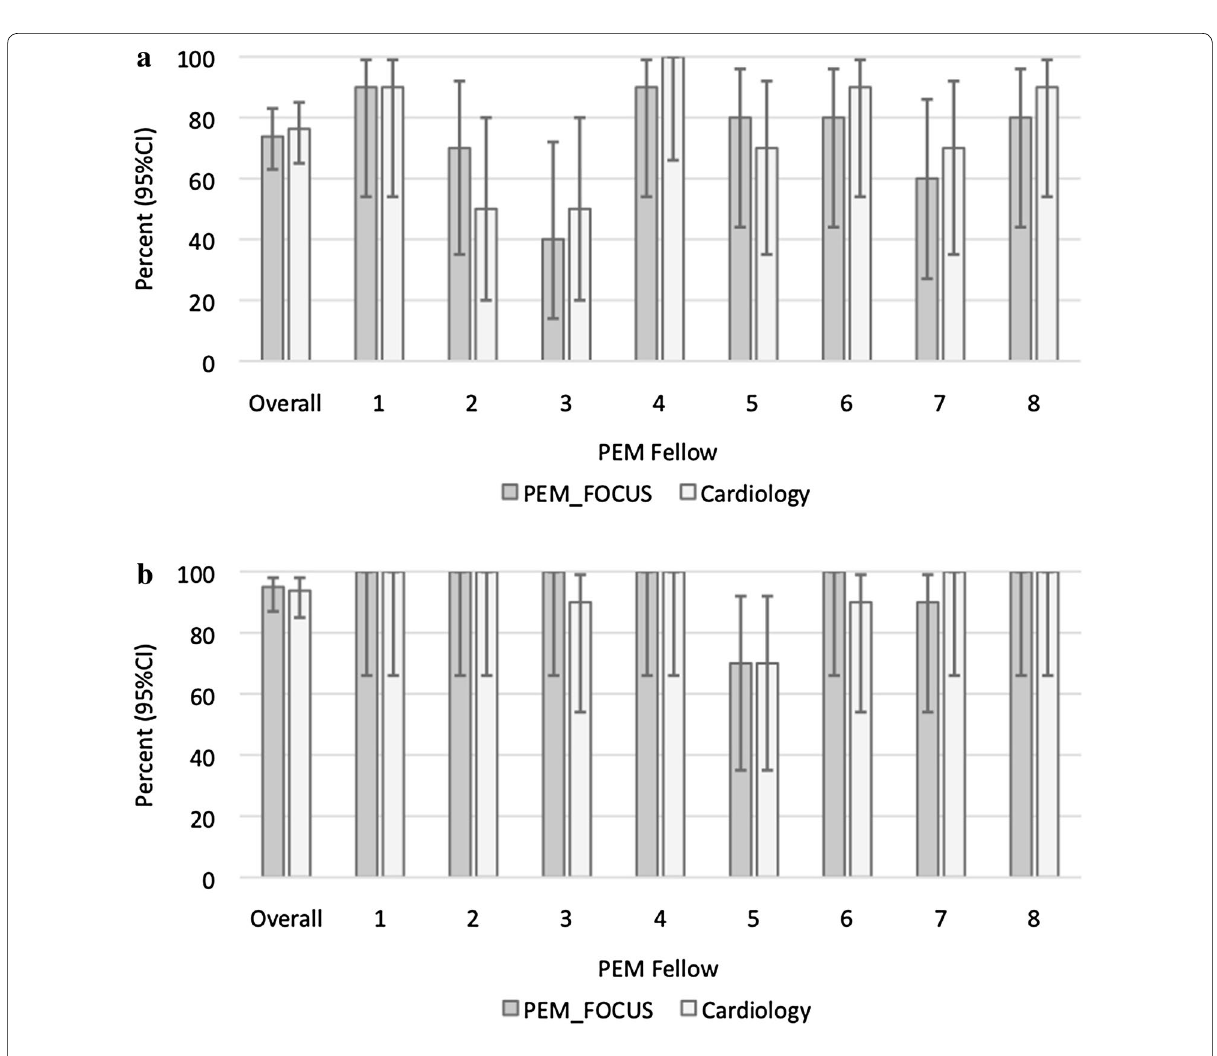
Fig. 4 Specificity of interpretation of classroom test of images of PEM FOCUS versus cardiology images by 8 PEM fellows for function ( a ) and effusion ( b